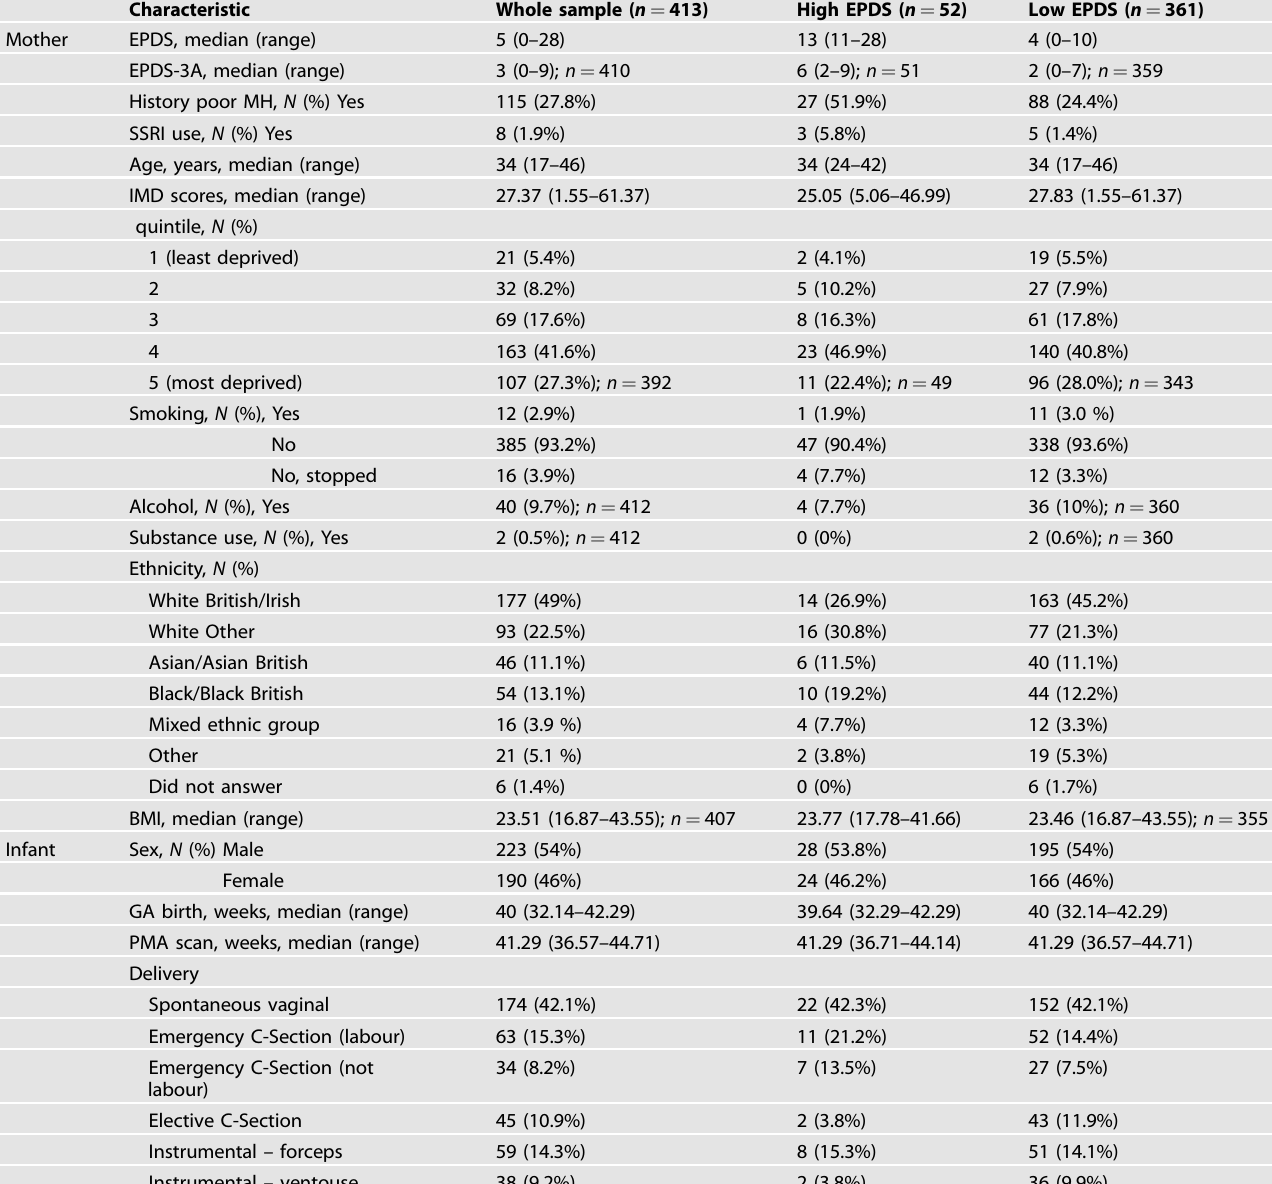
Table 1. Maternal and infant